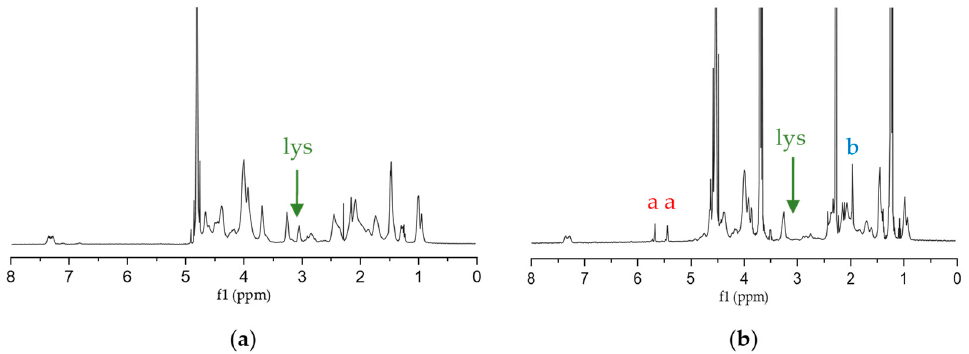
Figure 4. NMR spectra of ( a ) Greenland halibut gelatin; ( b ) Greenland halibut GelMA. “lys” in green corresponds to lysine methylene proton. Protons “a” in red and “b” in blue are associated with the methacryloyl group, as represented in the chemical structure of GelMA in Figure 1.